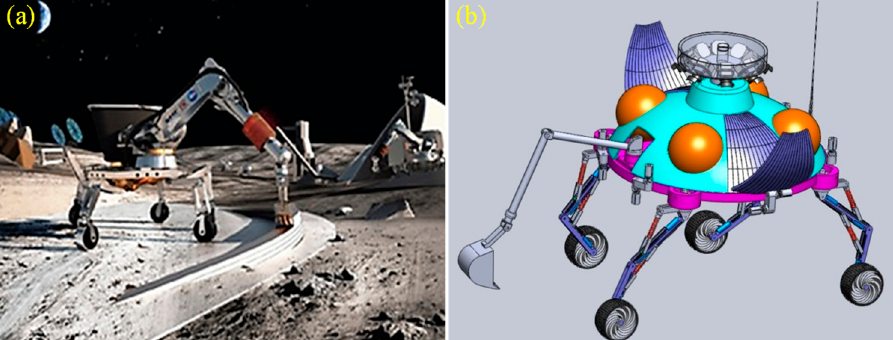
Figure 1. The lunar vehicle. ( a ) physical diagram, ( b ) three-dimensional model diagram.